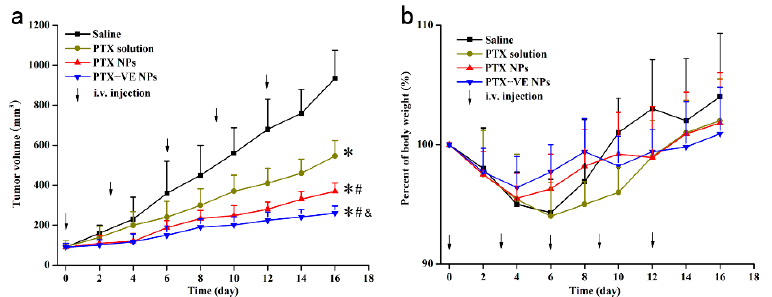
Figure 6. Anti-tumor effect of PTX formulations on the Balb/c mice implanted with MCF-7/ADR cells. Mice were injected through tail vein with Saline, PTX solution, PTX NPs and PTX-VE NPs, at a dosage of 10 mg/kg. The changes of tumor volume ( a ) and body weight ( b ) during 16-day treatments. (n = 6). * p < 0.05, significant difference when compared with Saline, # p < 0.05, significant difference when compared with PTX solution. & p < 0.05, significant difference when compared with PTX NPs.